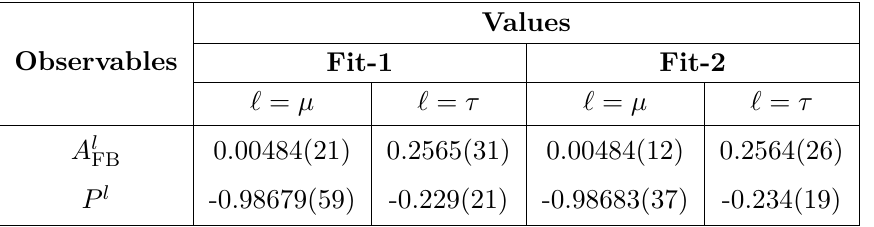
Table 8. SM values for angular observables related to the semileptonic B → π transitions. The values are provided for both muonic and tauonic final states corresponding to the Fit-1 and Fit-2 scenarios described in the text.